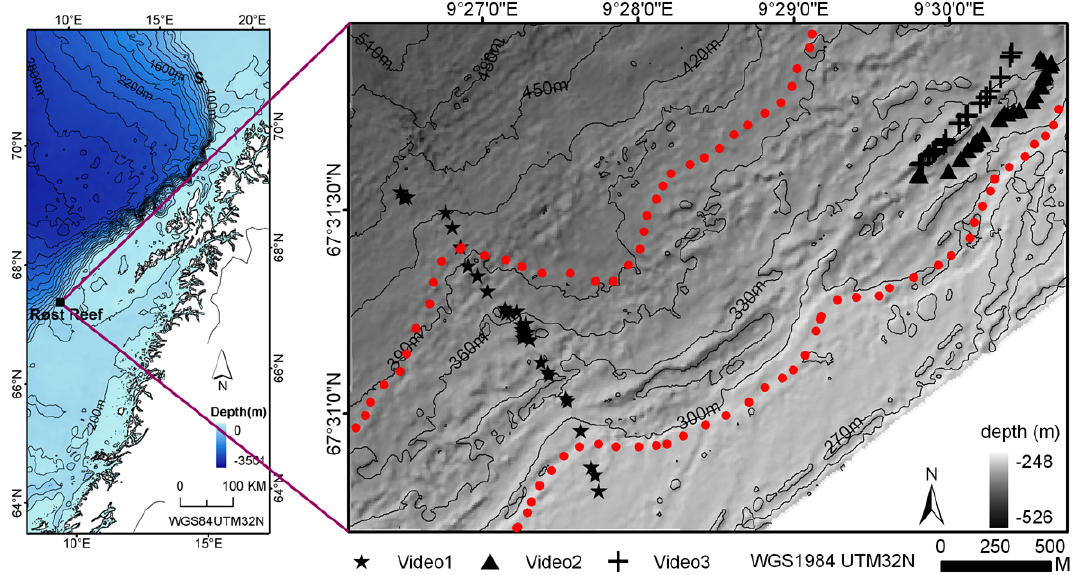
Fig. 3. Bathymetric map showing the location of the Røst Reef on the Norwegian margin, and the location of the three video transects analysed in this study. Red dots delineate reef microhabitat